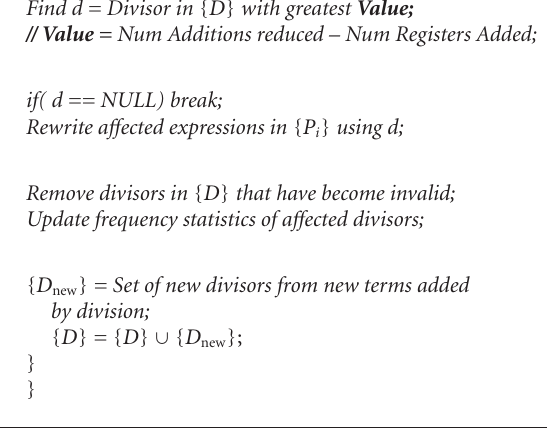
Algorithm 1: Modified CSE algorithm to reduce area: The divisors are generated for a set of expressions and the one with the greatest value is extracted. Then the common subexpressions can be extracted and a new list of terms is generated. The iterative algorithm continues with generating new divisors from the new terms, and add them to the dynamic list of divisors. The algorithm stops when there is no valuable divisor remaining in the set of divisors.